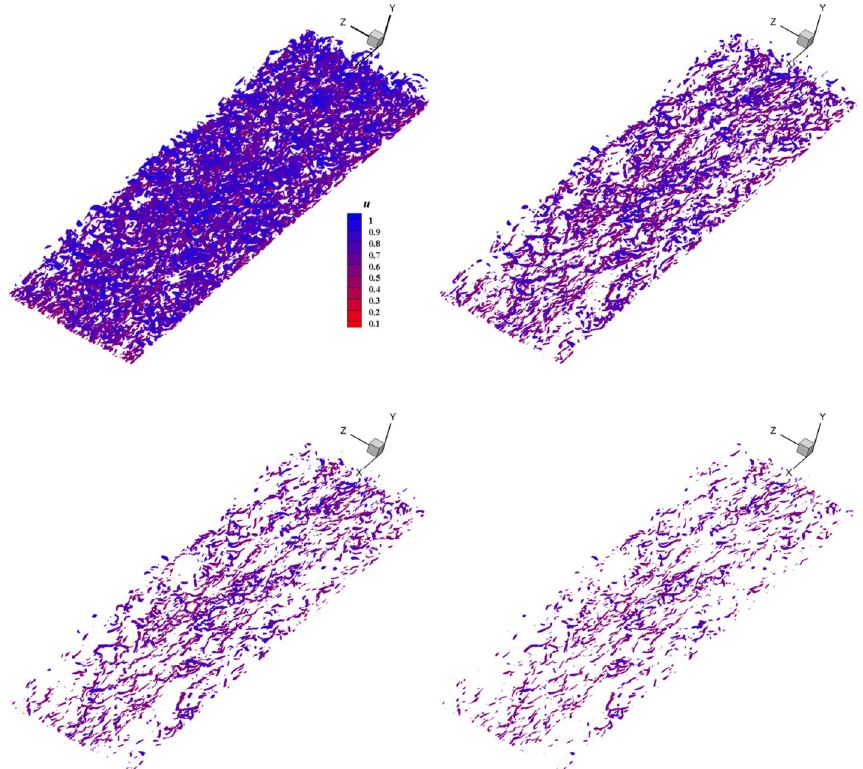
Fig. 27 The second-order invariant of the velocity gradient tensor Q 2 in the smooth-plate case (From top-left to bottom-right: